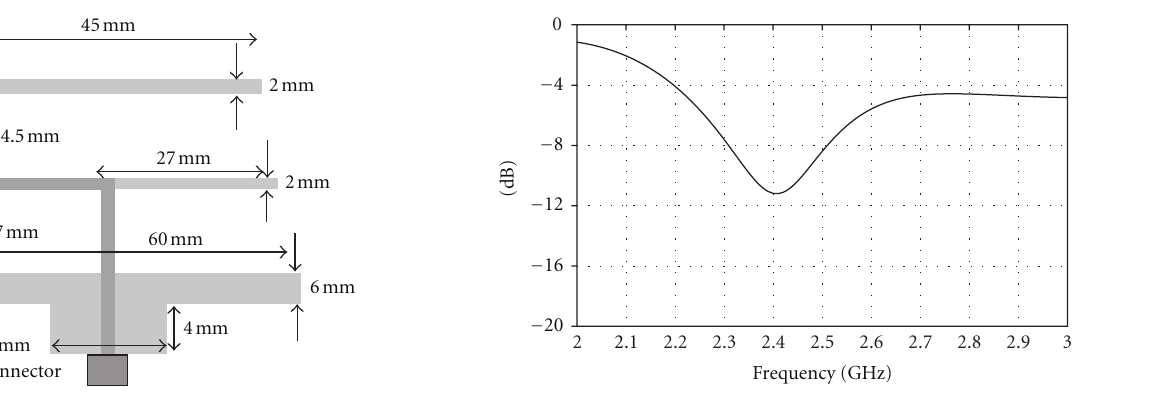
Figure 4: Geometry of the printed dipole antenna with reflector and director.